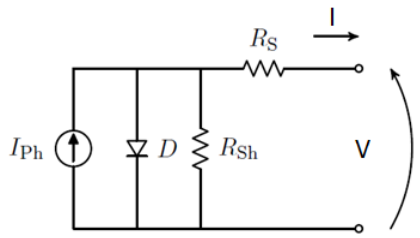
Figure 2. Electric model of a PV cell.